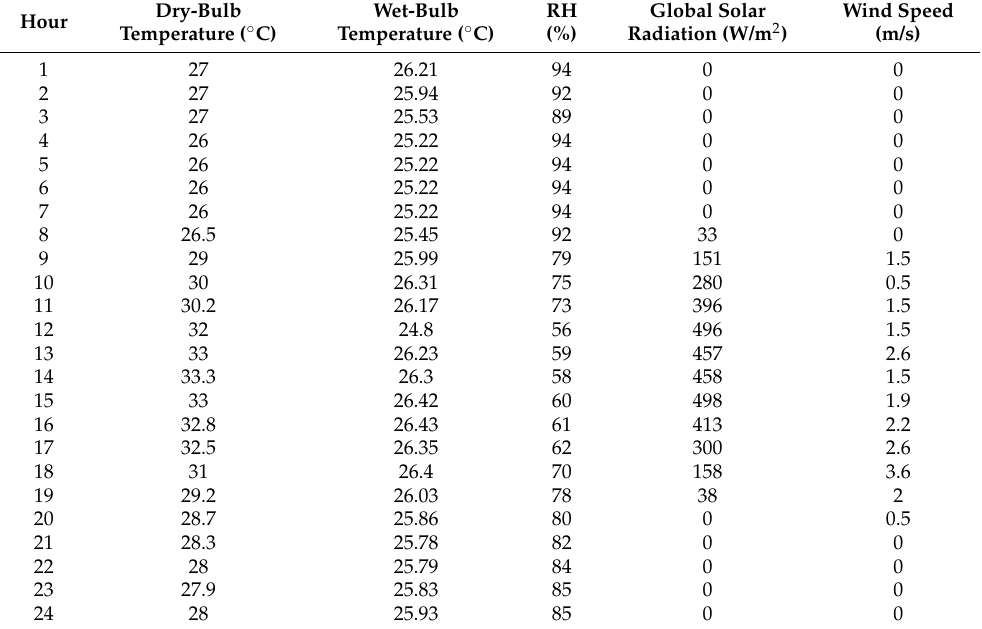
Table A1. Weather data of 30 April provided by